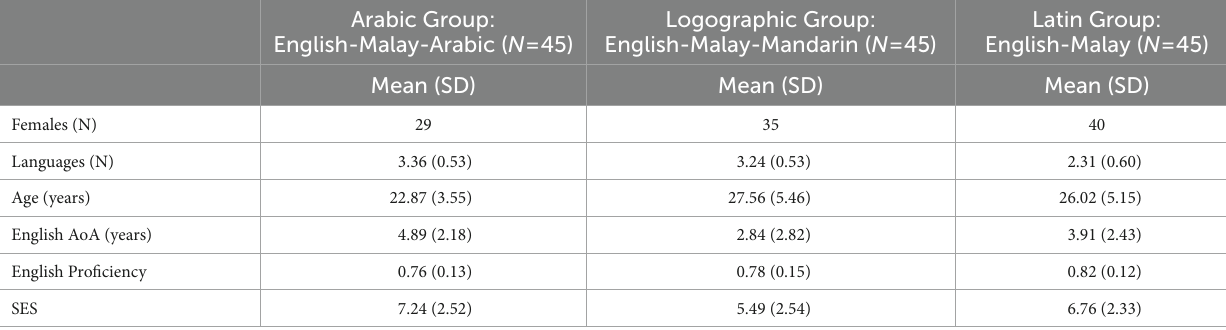
TABLE 1 Participant demographic information and language